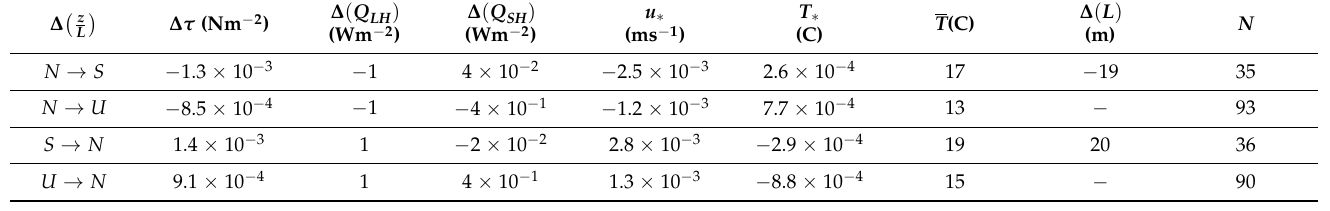
Table 3. The boundary layer parameter (Equation (7)) changes during shifts in the boundary layer Lz stability (BLS, ) in terms of tidal elevation. The number of samples of the BLS state conversions is incorporated in the last column of the table.